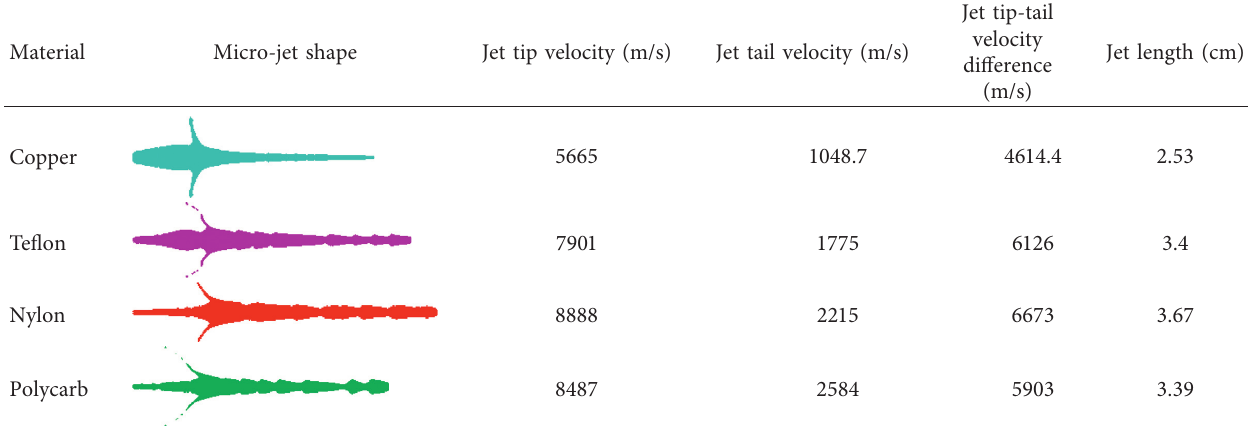
Figure 5: Variation curve of length with time before tensile fracture of different micro-jets. Table 3: Micro-shaped jet forming states of different materials ( t � 6 μ